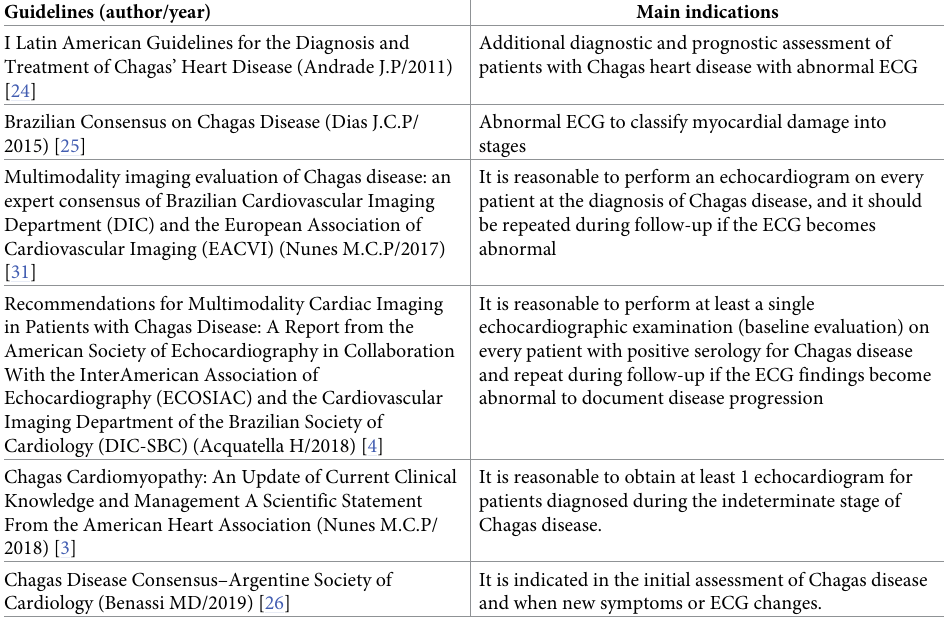
Table 6. Recommendations for echocardiogram in Chagas